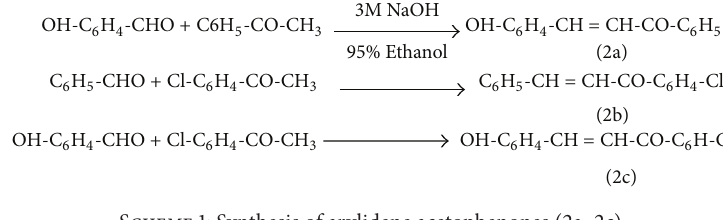
Scheme 1: Synthesis of arylidene acetophenones